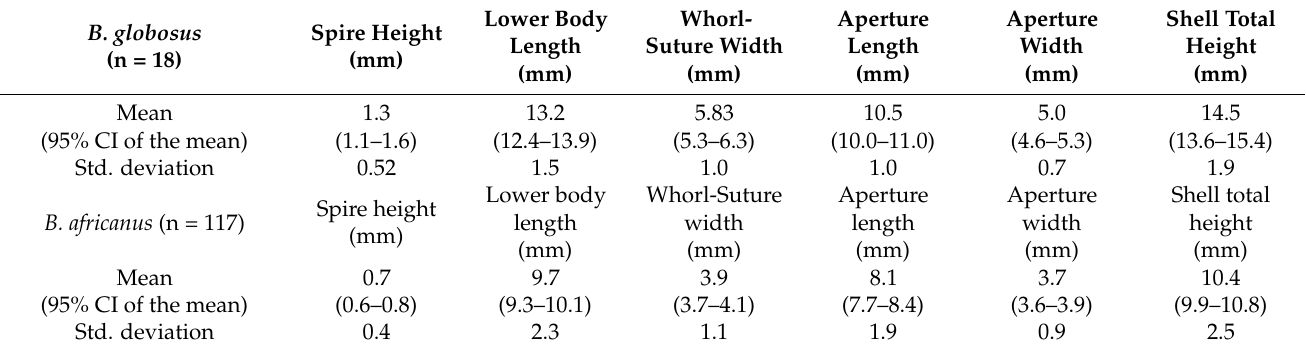
Table 1. Summary of the shell measurements for B. africanus